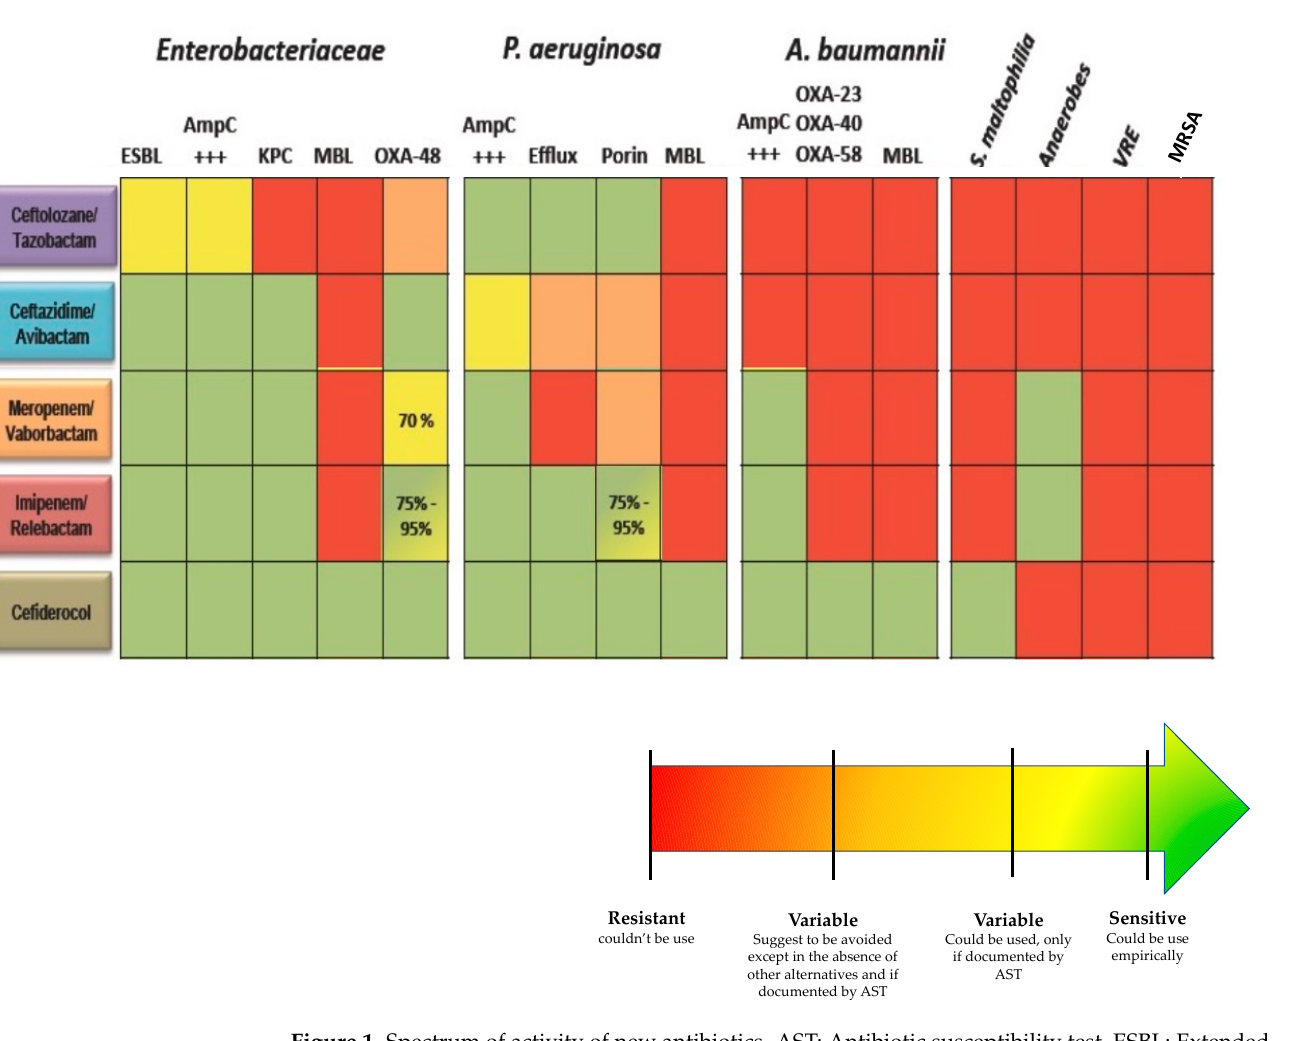
Figure 1. Spectrum of activity of new antibiotics. AST: Antibiotic susceptibility test, ESBL: Extended- spectrum beta-lactamase, AmpC: Cephalosporinase, KPC: Klebsiella pneumoniae carbapenemase, MBL: metallo-betalactamase, VRE: vancomycin resistant Enterococci, MRSA: Methicillin-resistant Staphylococcus aureus .